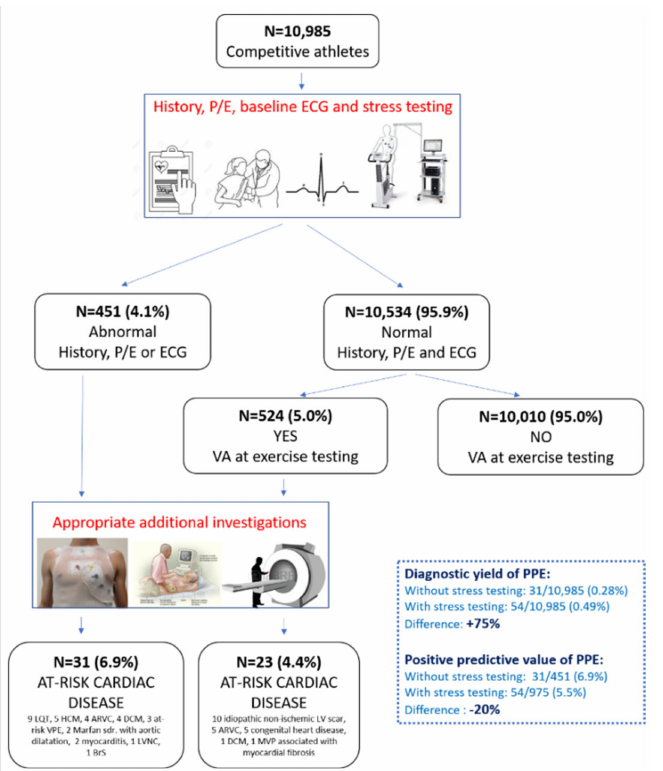
Figure 6. Summary of the main findings of a study investigating the additional value of exercise testing for ventricular arrhythmias in addition to history, physical examination and ECG in the setting of athletes’ preparticipation screening. Reproduced with permission from